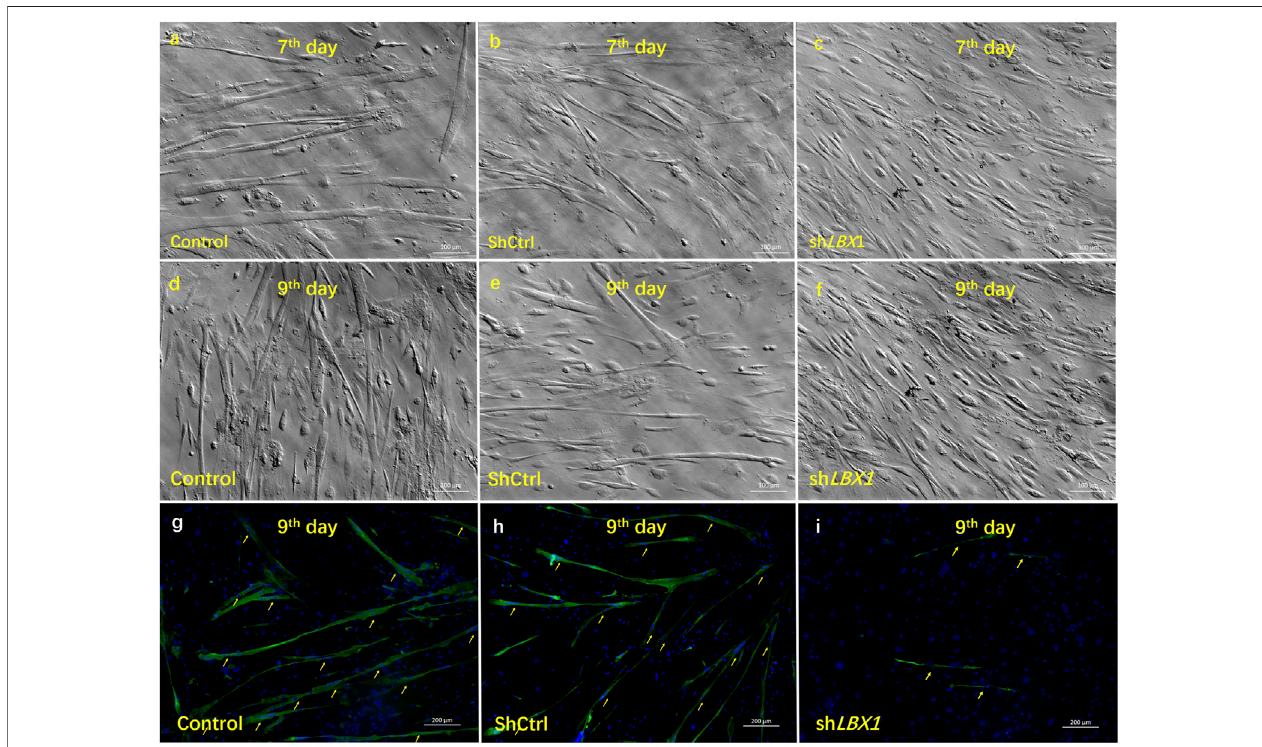
FIGURE 4 | The in fl uence of silencing LBX1 on the viability of MSCs. (A – F) For MSCs isolated from CS, LBX1 was knocked down via lentivirus transfection. Compared with the blank group and the ShCtrl group, decreased cell viability could be observed in the ShLBX1 group at the seventh day and the ninth day after MSC culturing.(G – H) MF20 wasstainedinred.DAPIwasstainedinblue.Immuno fl uorescencestainingshowedremarkablyfewerandsmallermyotube(arrows)intheSh LBX1 group at the ninth day of MSC culturing.